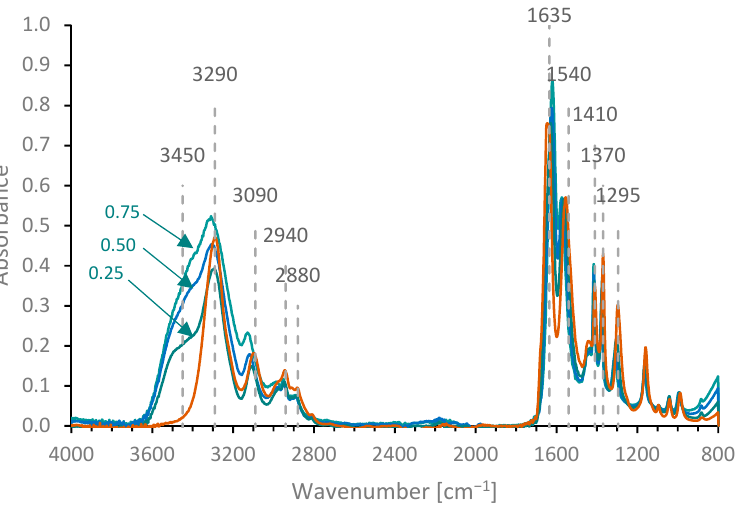
Figure 4. ATR-IR spectra of pure (liquid)NMAc (brown) and aqueous (25, 50 and 75%) NMAc solutions (turquoise), after subtraction of a pure water spectrum, using the weightings expected (as shown) and scaled to match the amide II peak intensity in the dry NMAc spectrum.